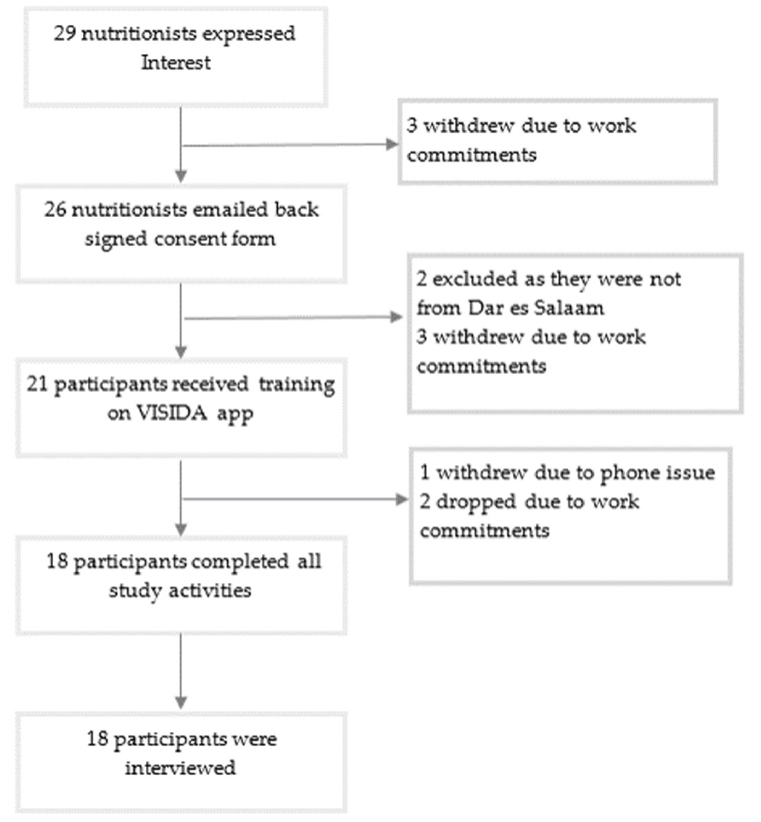
Figure 3. Participant recruitment and flow through the study.